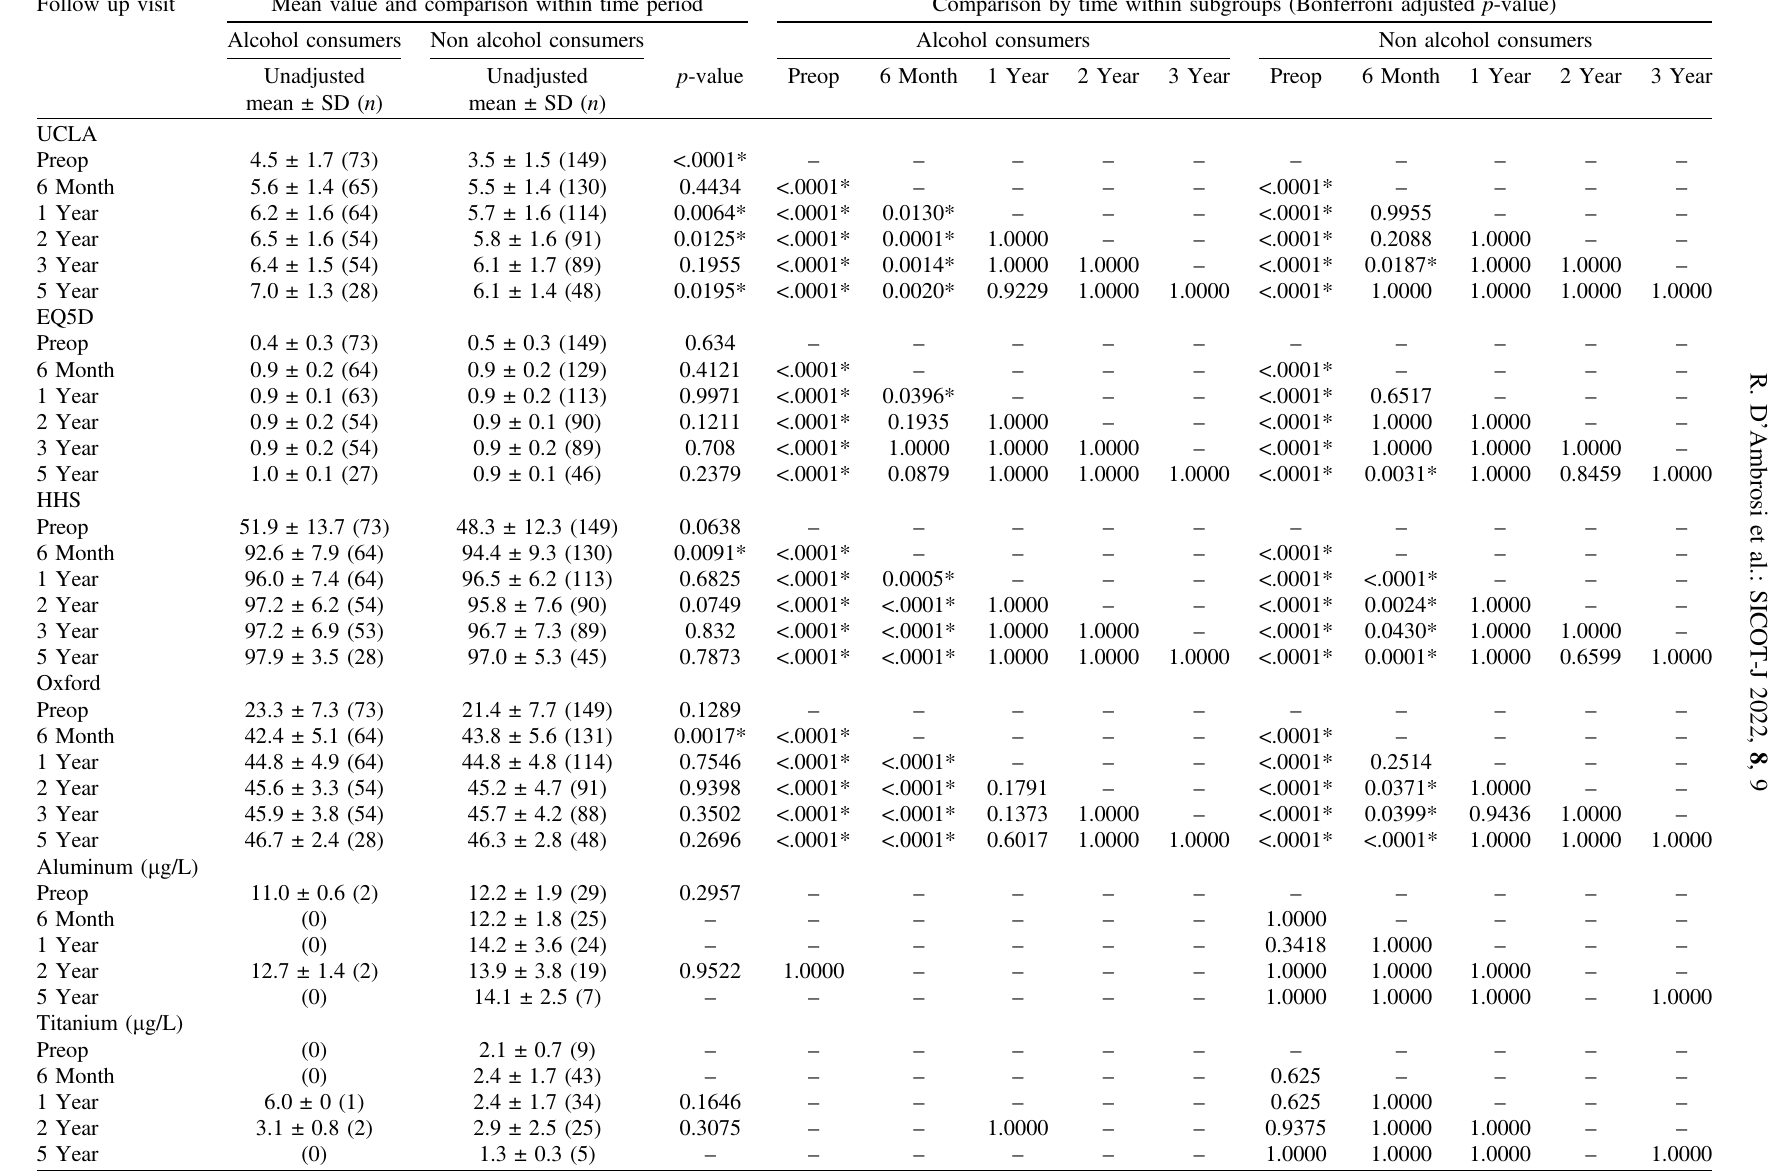
Table A.9. Subgroup analysis by alcohol